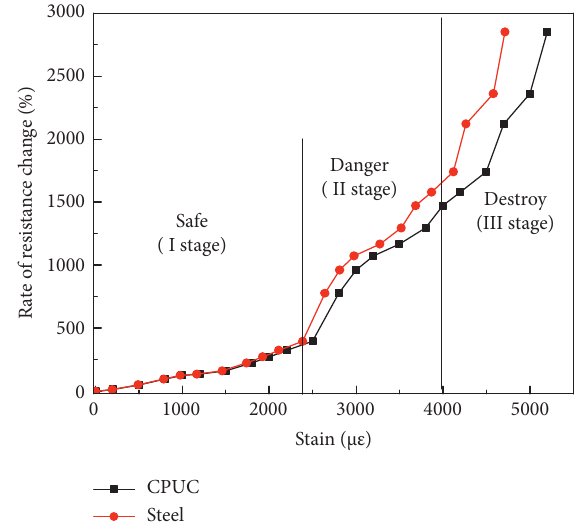
Figure 13: CPUC resistance change shown in the rate-strain re- lation curve.